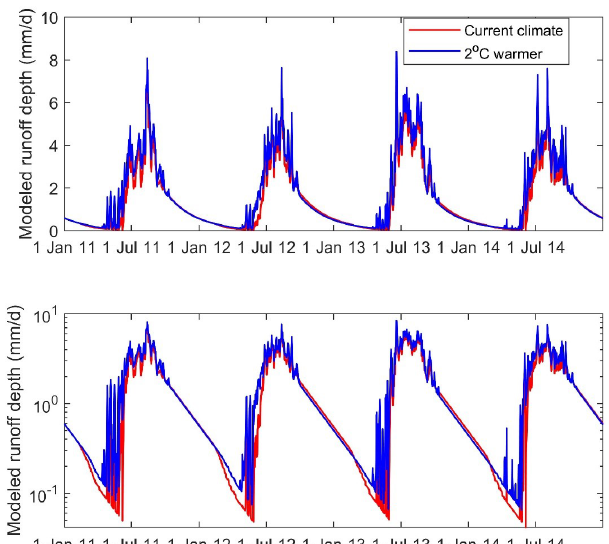
Figure 12. Simulated hydrograph in current climate condition, and the 2 ◦ C warmer